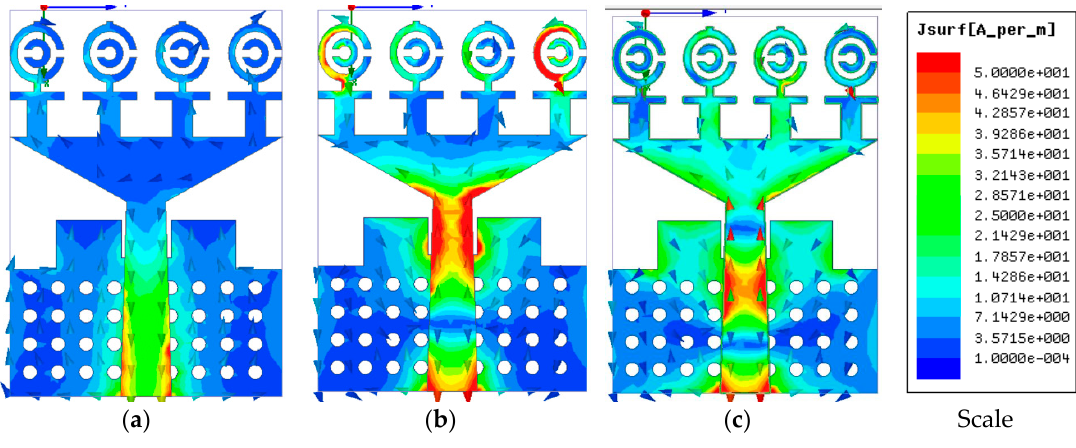
Figure 7. The surface current distribution at ( a ) 3.25, ( b ) 6.5, and ( c ) 9.5 GHz.